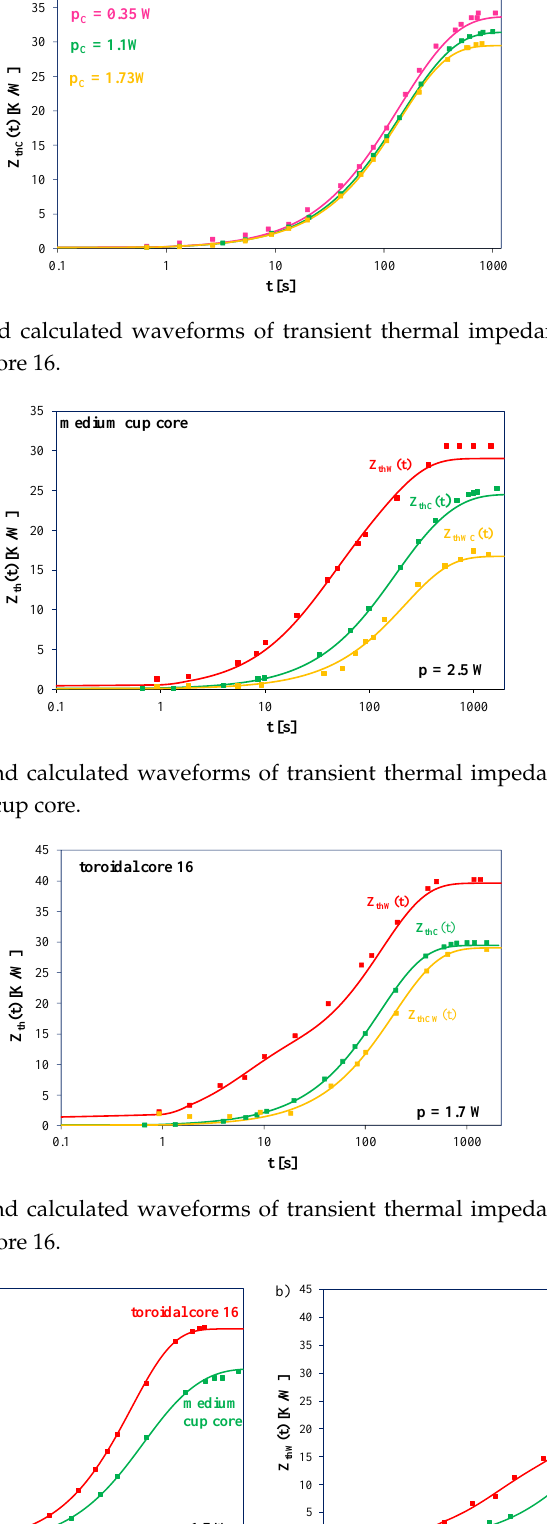
Figure 12. Measured and calculated waveforms of transient thermal impedances of the core ( a ) and of the winding ( b ) for inductors containing each considered core.